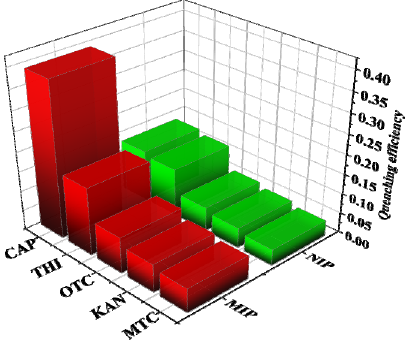
Figure 10. Quenching efficiency of MIP@SiO 2 @QDs and NIP@SiO 2 @QDs (the concentration of CAP, THI, OTC, KAN and MTC is 100.0 μ mol·L − 1, respectively).